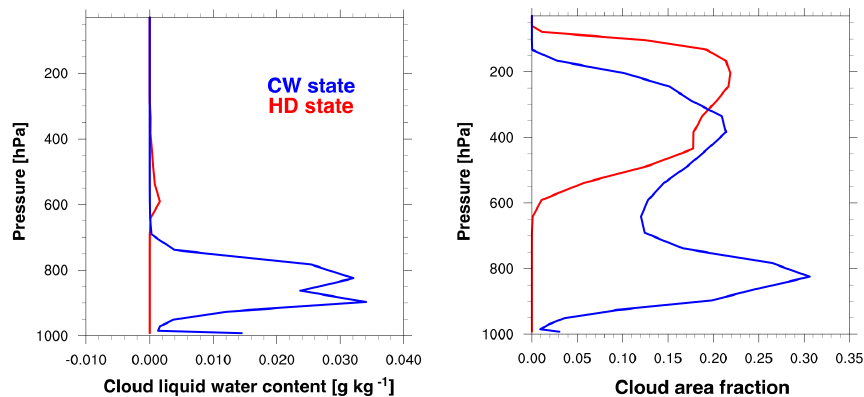
Figure 3. Vertical profiles of cloud liquid water content (gkg − 1 ) and cloud area fraction averaged over the low-latitude region (30 ◦ S–30 ◦ N) for the two terra-planet states in the simulations Z14 and